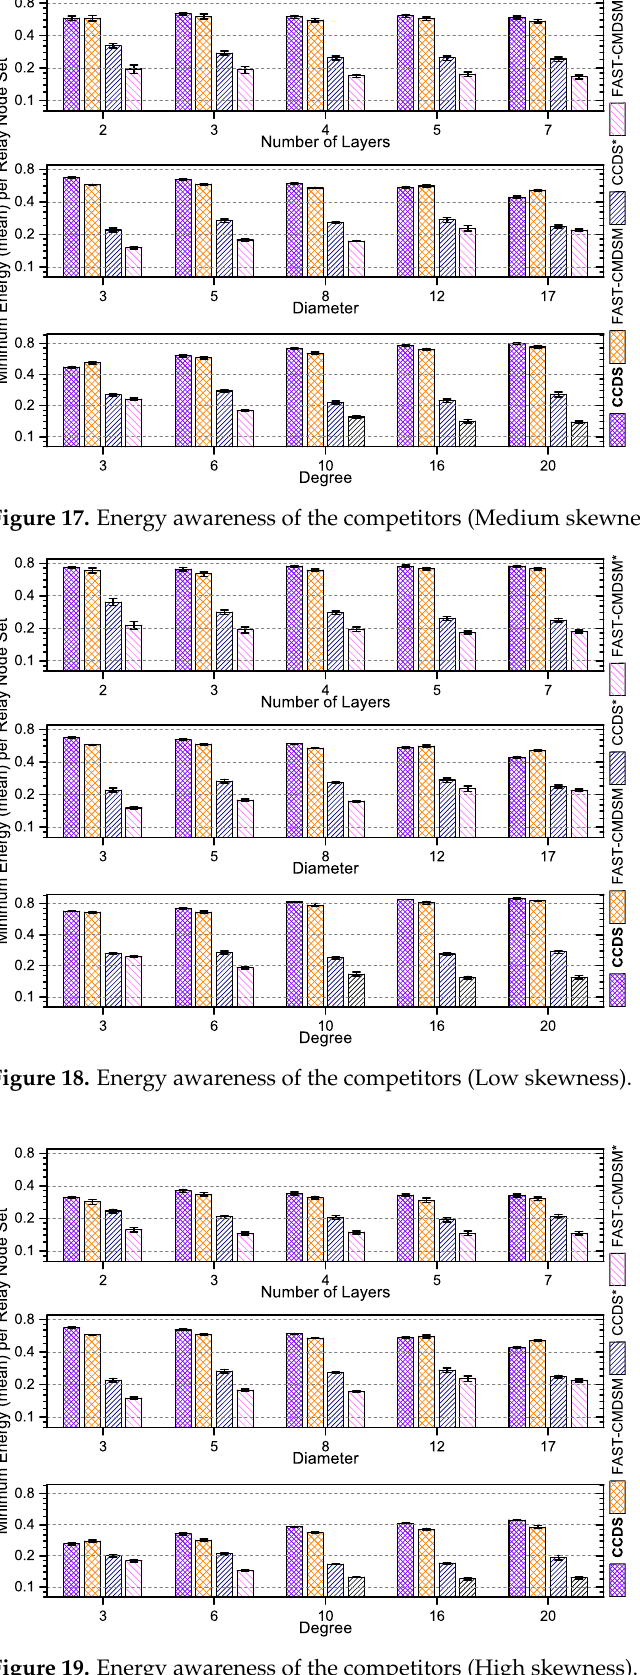
Figure 19. Energy awareness of the competitors (High